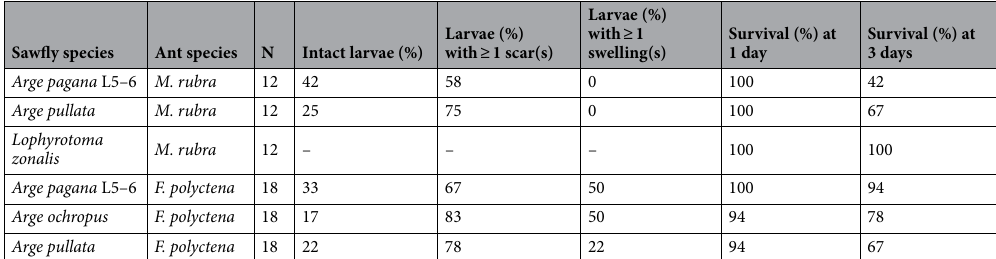
Table 3. Health state and survival of sawfly larvae following long-term interactions with ants of Myrmica rubra and Rhytidoponera metallica . Sawfly-ant interactions lasted for 24 h, i.e. from t = 0 to 1 day. Number of experiment repetitions (N). The percentage of intact larvae is given, based on the health state of the larvae that was recorded at t = 1 day; intact larvae demonstrated no visible signs of scars and swellings. The survival of the larvae was recorded at t = 1 day and 3 days. (L5-6) Larvae at instars 5 and 6. (–) Not recorded.